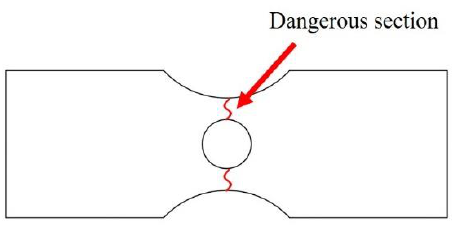
Figure 13. Diagram of dangerous section of the supporting ring.